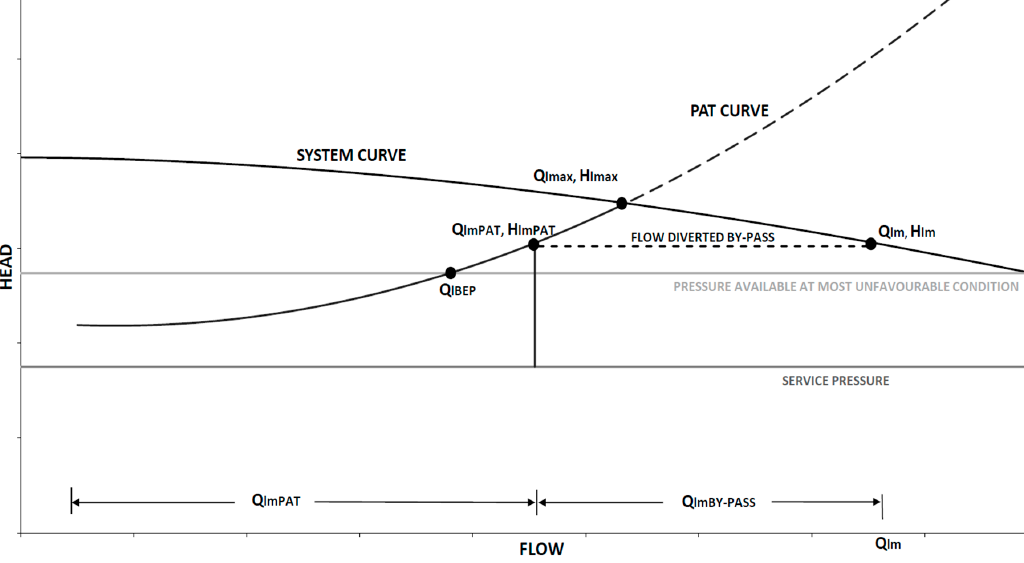
Figure 4. Representation of a potential PAT flow-head curve for a hypothetical site, and working pairs ( Q lmPAT , H lmPAT ) for a random flow Q lm greater than the maximum Q lMAX in the Q-H space.